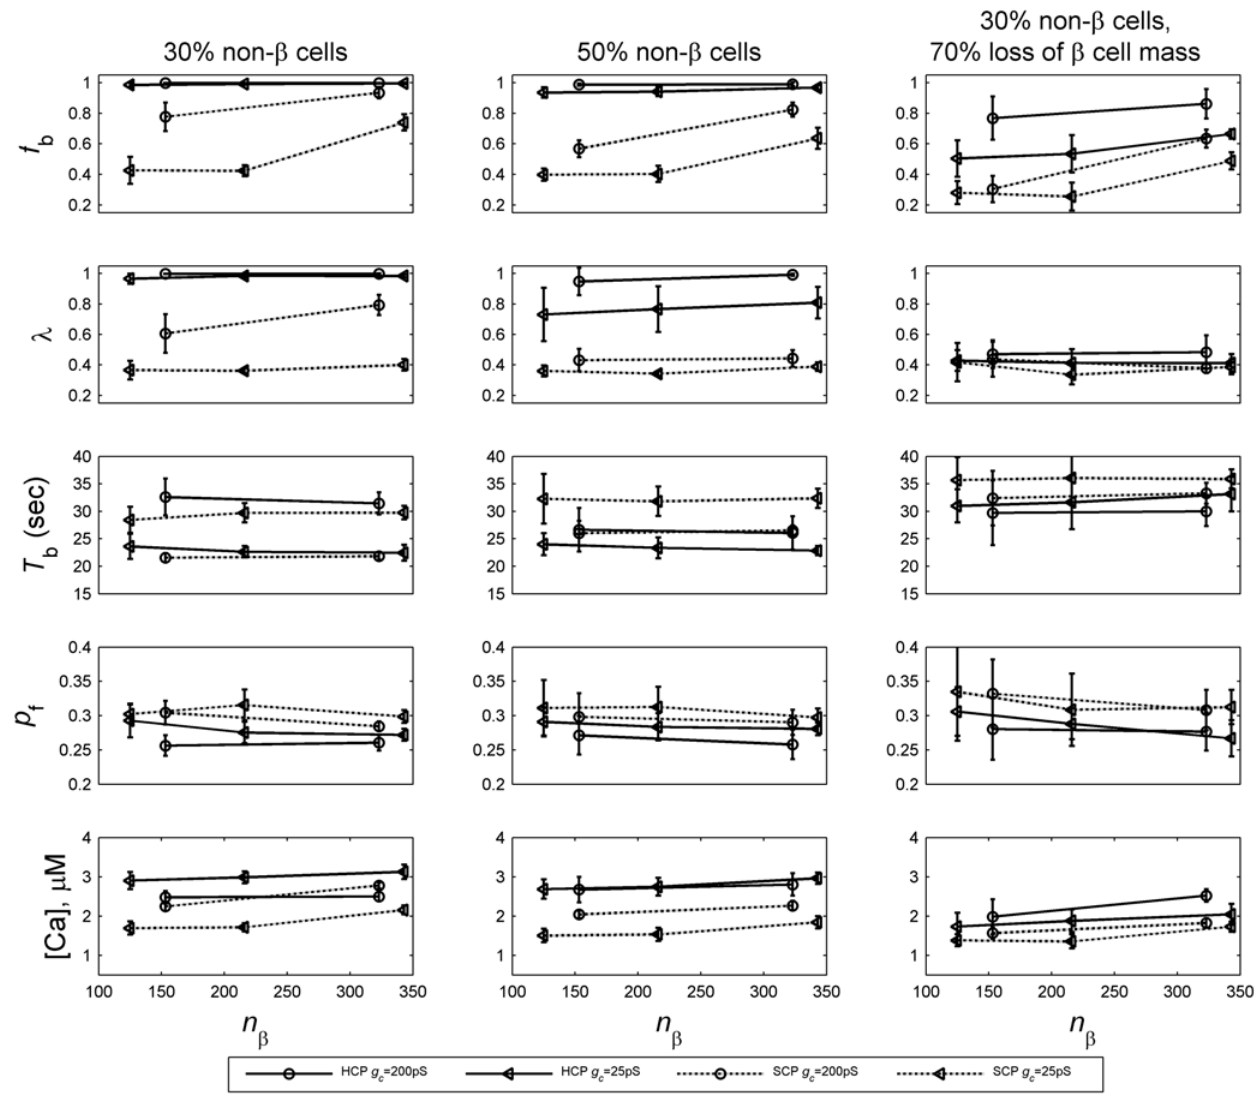
Figure 5. Function of a b -cell cluster versus its size n b . Left and middle columns: at normal coupling strength and no loss of b cells, no significant dependence is observed in the HCP b -cell clusters (solid lines). This is true even when the intercellular coupling is impaired to a very low value of 25 pS. Right column: when there is extensive b -cell loss at 70%, marginal functional gain is observed in f b and [ Ca ].